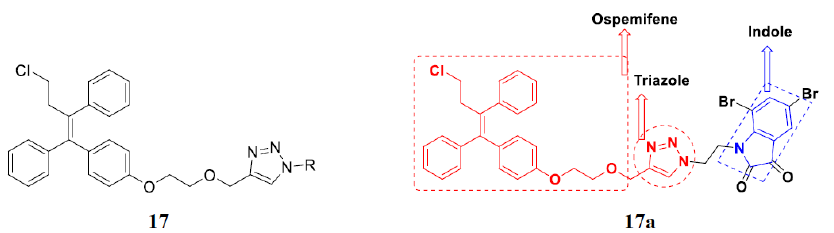
Figure 19. Structure of indole-ospemifene-triazole based hybrids and the most promising com- pound 17a. Table 17. In vitro cytotoxic activities of indole ‐ ospemifene ‐ triazole based hybrid compounds 17 ( b – e ).